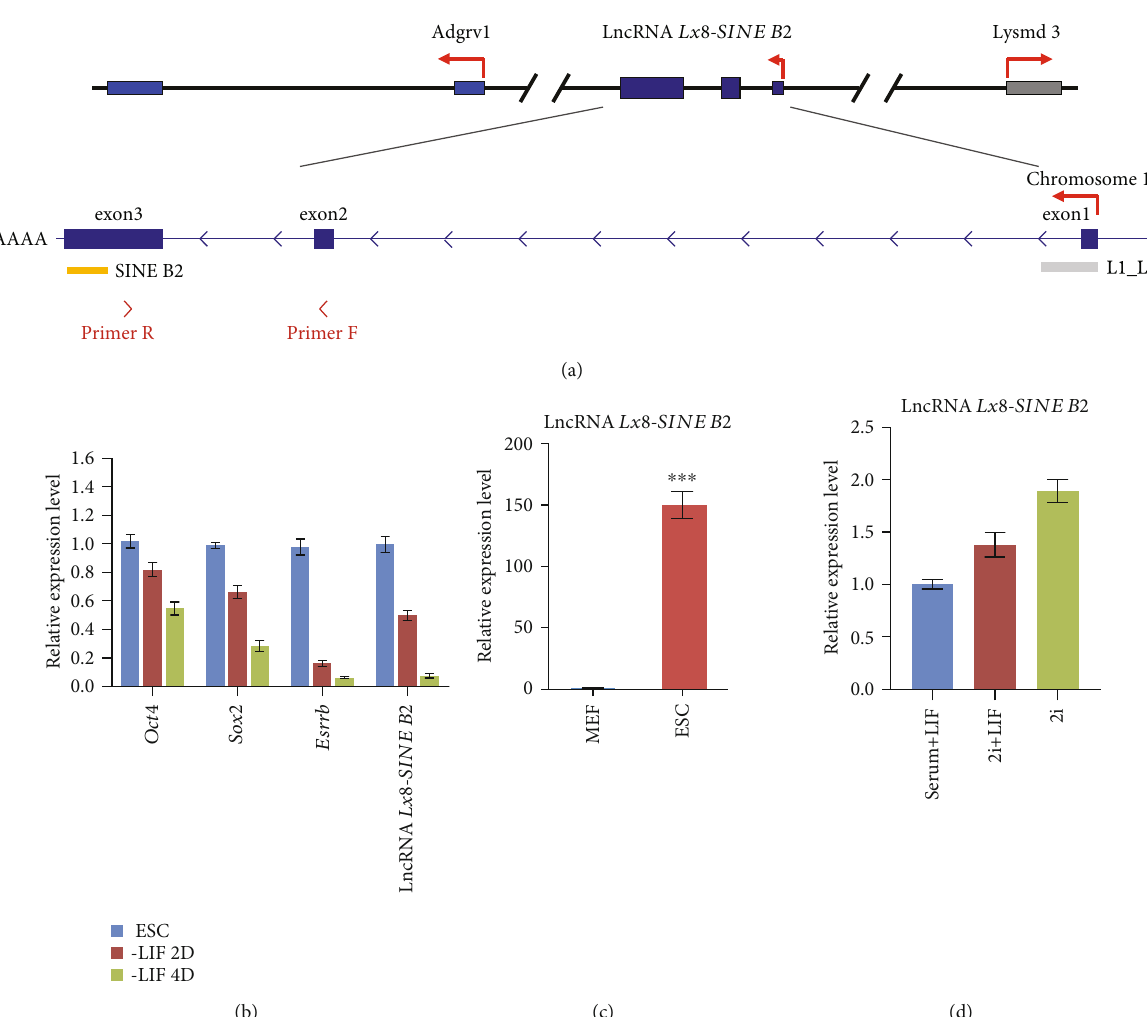
Figure 2: Genomic location and expression of lncRNA Lx8-SINE B2 . (a) Schematic of the mouse lncRNA Lx8-SINE B2 locus on chromosome 13. lncRNA Lx8-SINE B2 is between Adgrv1 and Lysmd3 . There are three exons and some retrotransposon fragments of LINE or SINE in lncRNA Lx8-SINE B2 . RT – qPCR primers were indicated below. (b) The expression level of lncRNA Lx8-SINE B2 , Oct4 Sox2 , and Esrrb in mESCs in the presence or absence of LIF for 2-4 days, as measured by RT – qPCR and normalized to Gapdh levels. Biological-triplicate data ( n = 3 dishes) are presented as mean ± s : e : m . (c) qPCR analysis of the expression level of lncRNA Lx8-SINE B2 in mouse ESCs and MEF cells. ∗∗∗ p < 0 : 001 according to two-sided Student ’ s t -test (d) Expression analysis of lncRNA Lx8-SINE B2 in ESCs cultured under serum/LIF, 2i/LIF or 2i condition. Biological-triplicate data ( n = 3 extracts) are presented as mean ± s : e : m